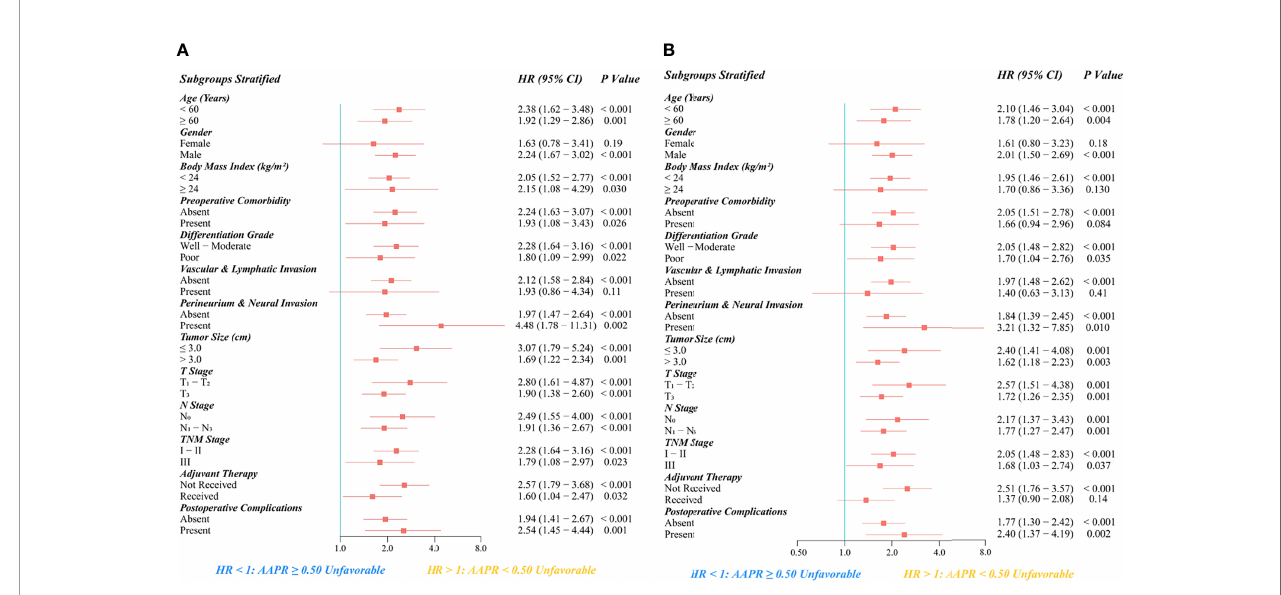
FIGURE 7 | Subgroup analysis regarding the prognostic signi fi cance of preoperative AAPR on (A) OS and (B) PFS after esophagectomy for ESCC.